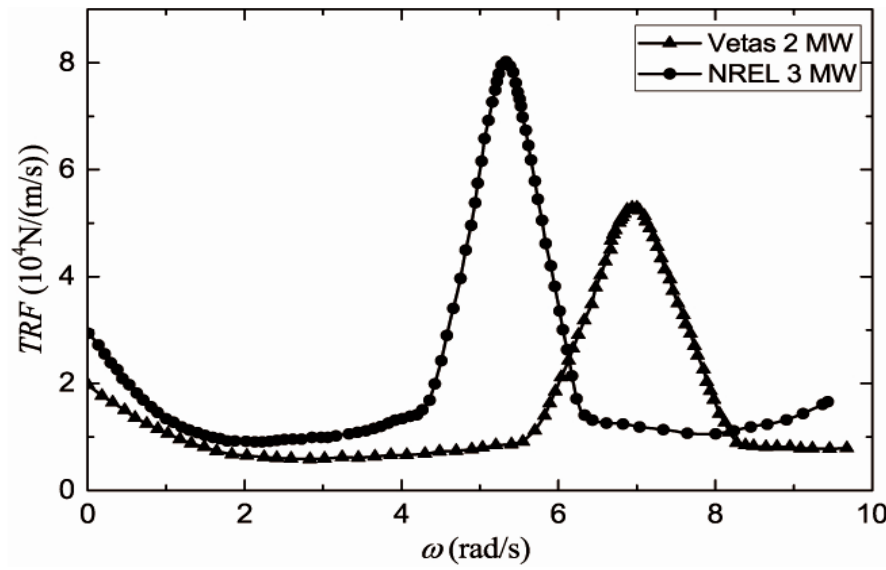
Figure 2. Transfer function (TRF) from wind speed to tower-top load [41].